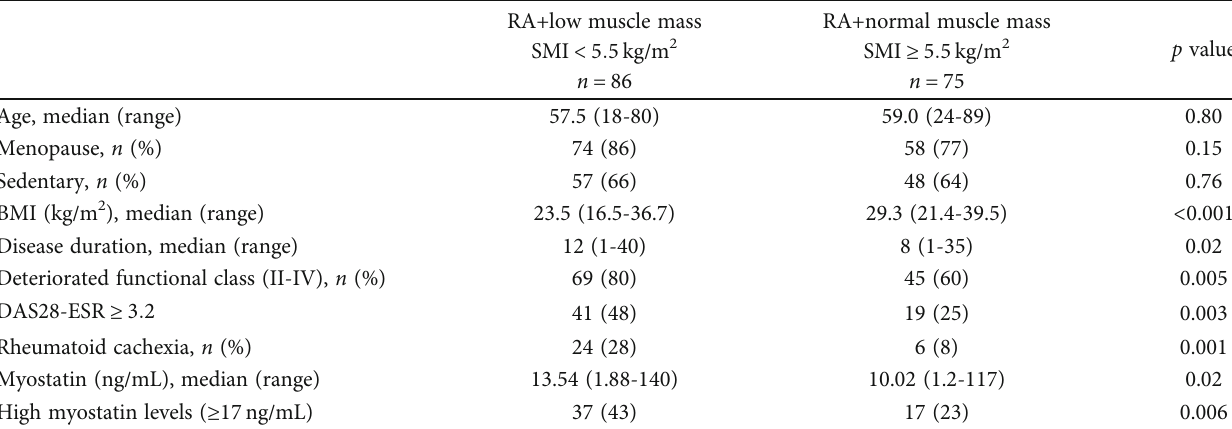
Table 2: Comparison of clinical characteristics between RA patients with and without low muscle mass in the univariable